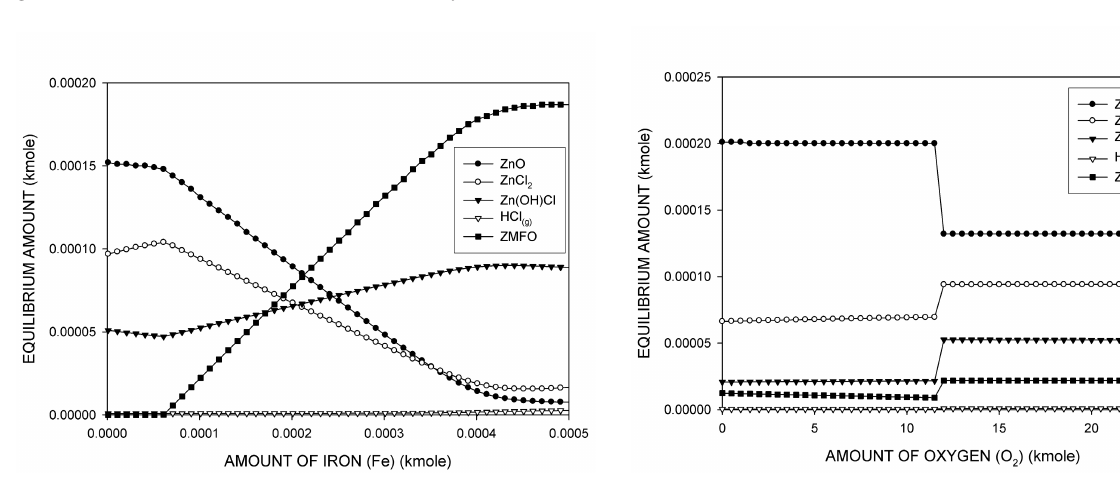
Figure 3(a). Effect of the amount of chlorine on the equilibrium amounts of the zinc-containing species and gaseous HCl for the Zn-Fe-Mn-O-H-C-Cl system.